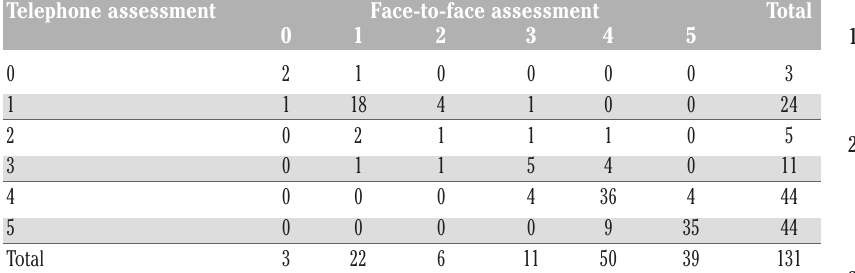
Table 1. Modified Rankin Scale: cross-tabulation of scores assessed by telephone and face- to-face interview. Telephone